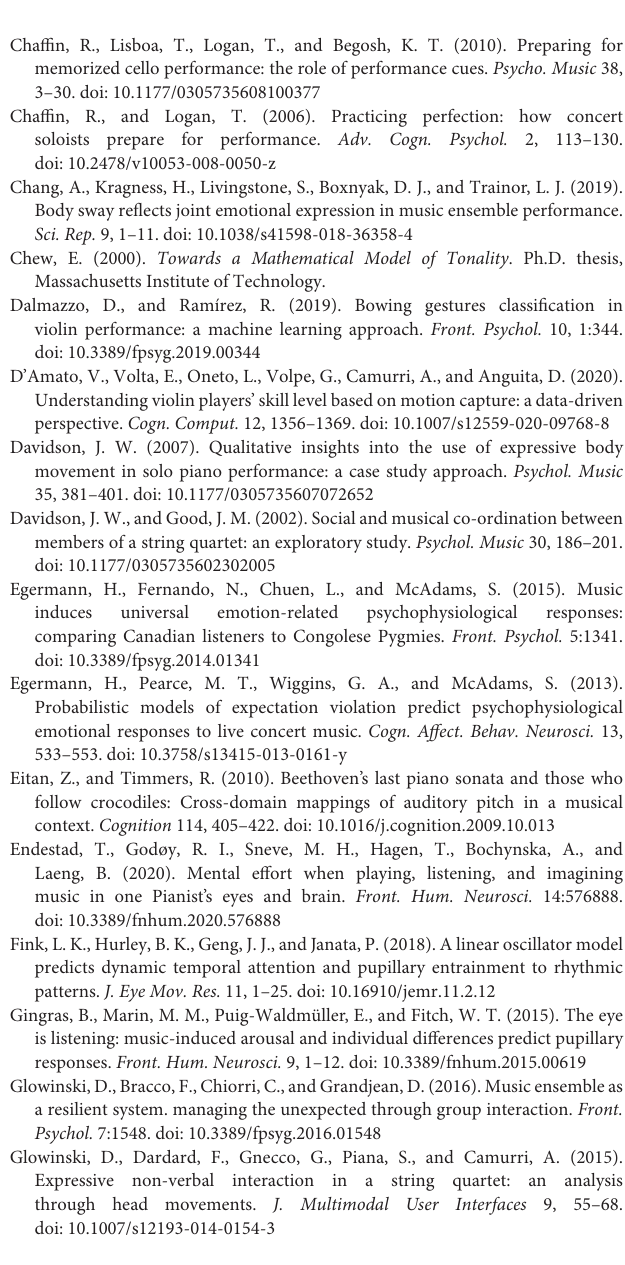
Supplementary Figure 2 | Violin plots showing the distribution of ratings of Technical difficulty given by each musician across pieces. Supplementary Figure 3 | Violin plots showing the distribution of ratings of Harmonic Complexity given by each musician across pieces. Supplementary Figure 4 | Violin plots showing the distribution of Cloud diameter values across pieces. Supplementary Figure 5 | Violin plots showing the distribution of ratings of Expressive difficulty given by each musician across pieces. Supplementary Figure 6 | Violin plots showing the distribution of Quantity of Head Motion values for each musician across